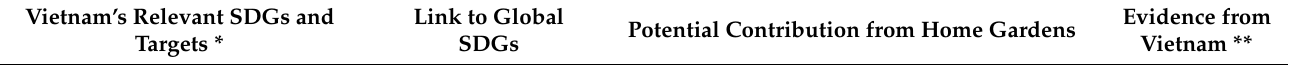
Table A1. Potential contributions of home gardens in Vietnam to Vietnam’s sustainable development goals (source: World Agroforestry, data